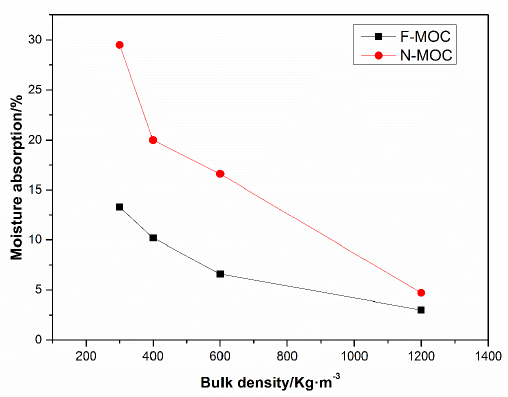
Figure 13. Moisture absorption rate of F-MOC and MOC with a different bulk density.